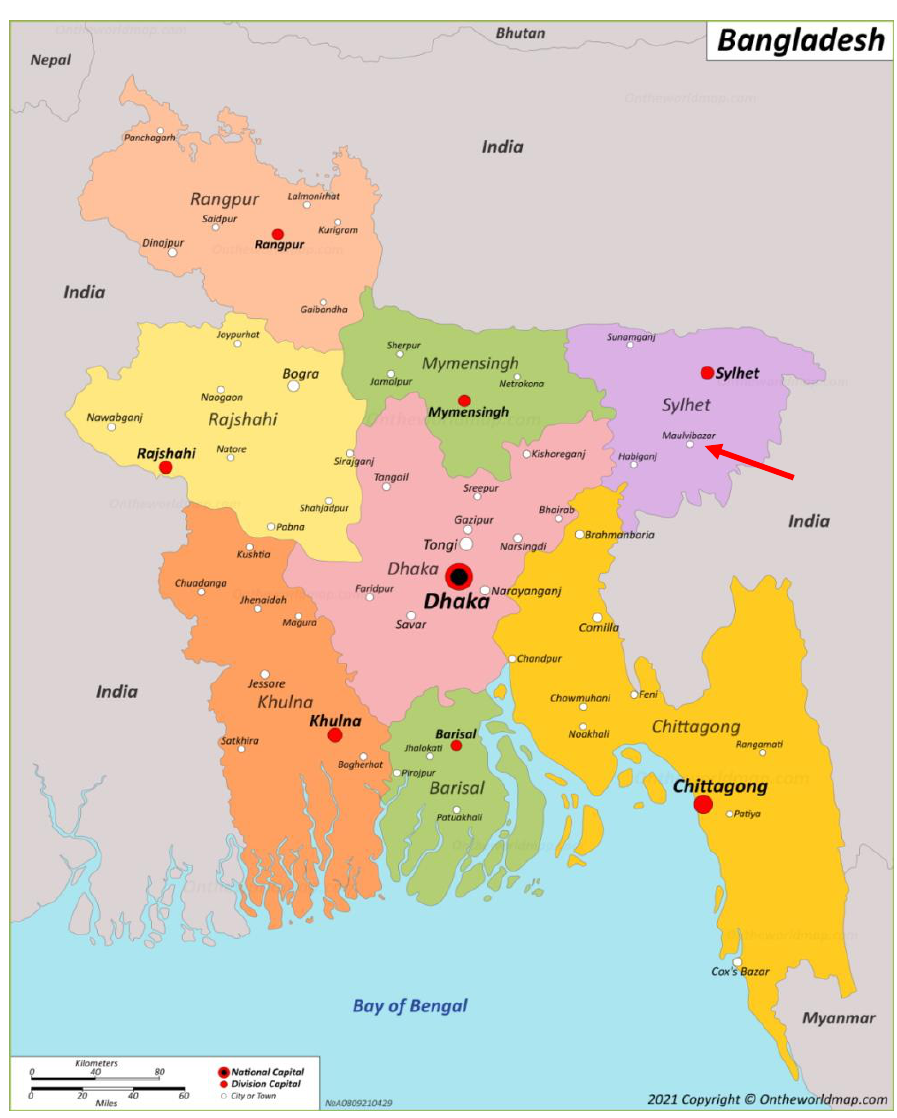
Figure 1. Map of Bangladesh [17] showing divisions and districts (red arrow pointing to study lo- cation).